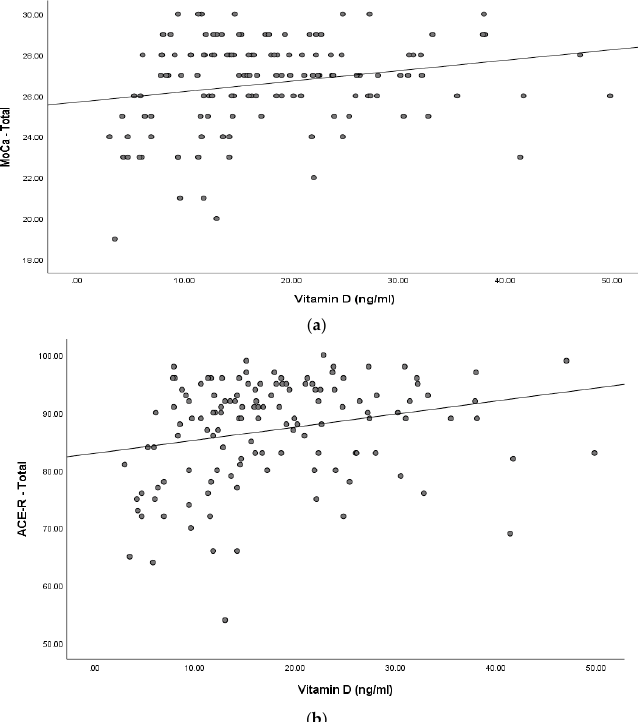
Figure 2. ( a ) Correlation between serum vitamin D levels and cognitive function by groups on the MoCa test. Note: MoCa Total- the Montreal Cognition Assessment total score. ( b ) Correlation between serum vitamin D levels and cognitive function by groups on the ACE-R scale. Note: ACE- R Total—Addenbrooke’s Cognitive Examination—Revised total score. Furthermore, the results showed that there was no statistically significant correlation in individual groups of respondents (Table 3). Table 3. Correlations between vitamin D levels and tests by individual groups.